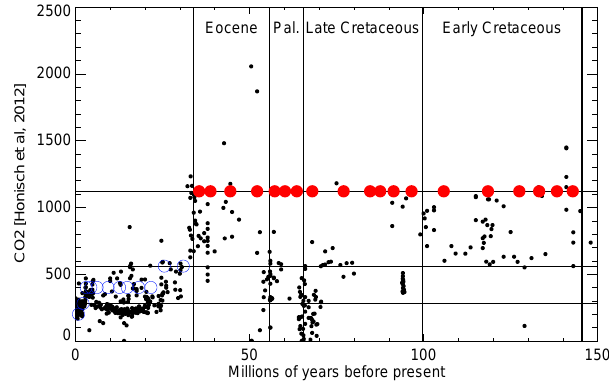
Figure 3. CO 2 as compiled by Honisch et al. (2012) (small dots). Overlain is the CO 2 concentration in each simulation described in this paper (red dots). The open blue circles show CO 2 concentra- tion in a set of model simulations of the Oligocene and Neogene, which are not discussed in this paper but are provided for reference. Horizontal black lines show 280, 560, and